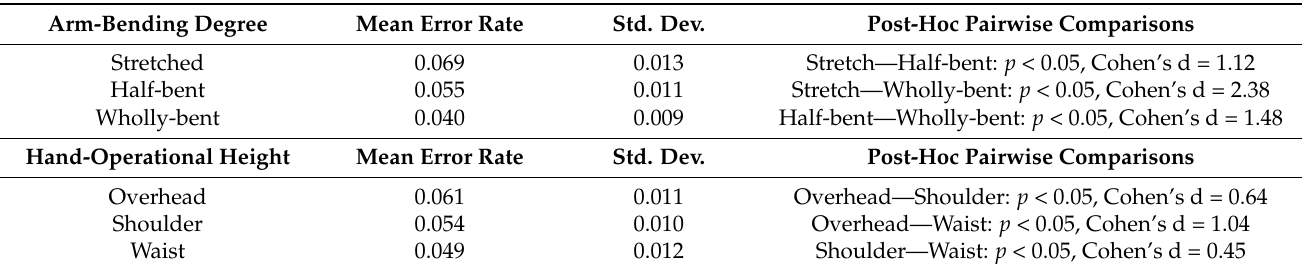
Table 3. Target acquisition error rate in different conditions of the arm-bending degree and the hand-operational height, and pairwise comparisons.